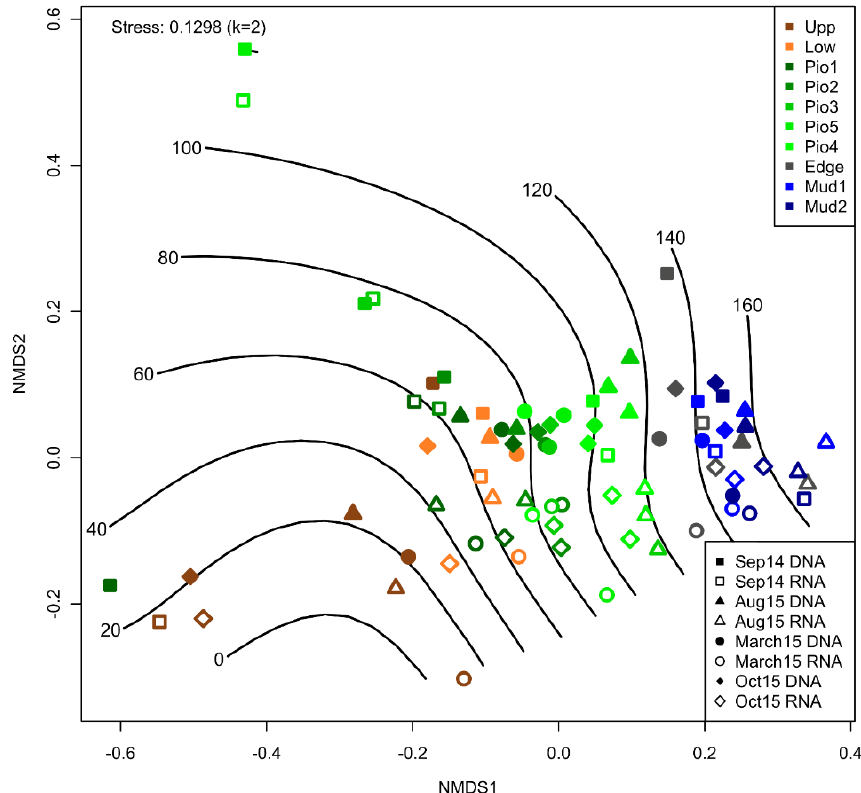
Figure 2. Distance – decay analysis. Pairwise Bray – Curtis dissimilarity over the geographic distance for ( A ) 16S rRNA genes (DNA-based) and ( B )-transcripts (RNA-based), independent of location and season. The red line represents a fitting linear model, with the 95% confidence level interval as the shaded area.